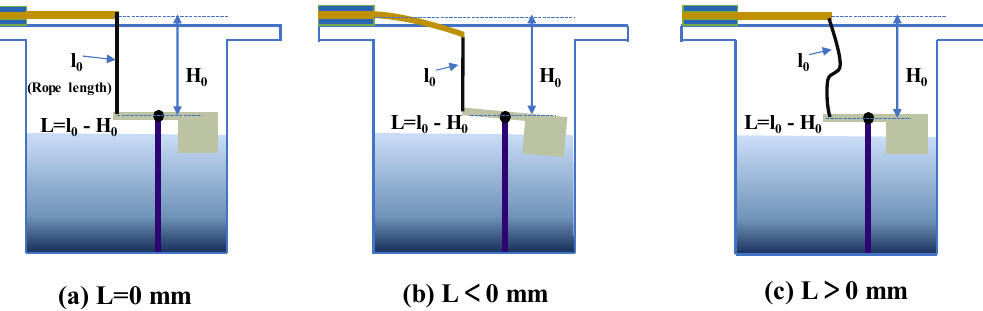
Figure 4. Schematic of the rope margin: ( a ) rope margin L = 0; ( b ) rope margin L < 0; ( c ) rope margin L > 0.